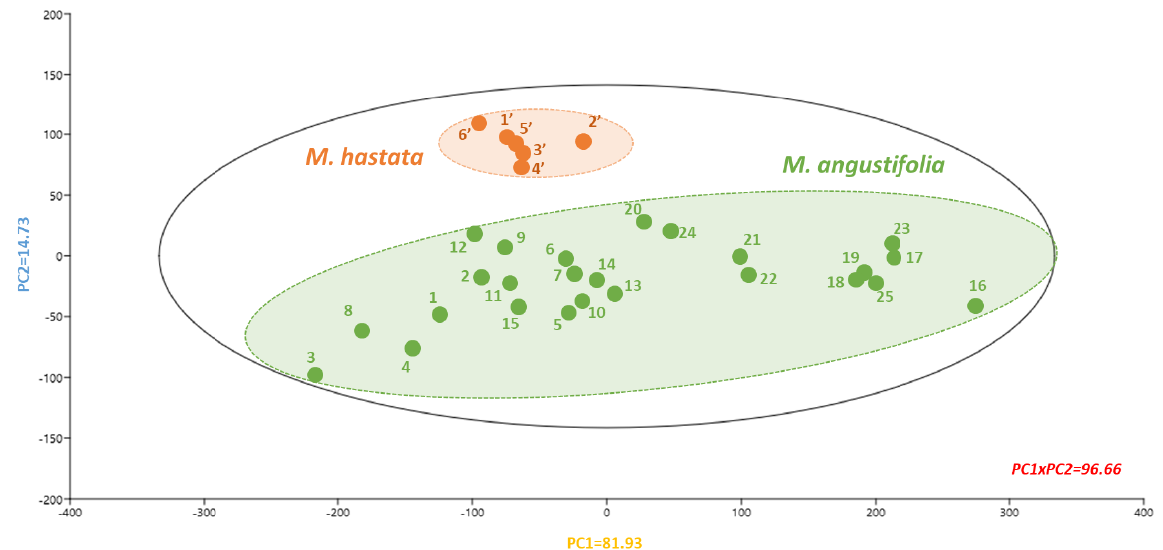
Figure 8. Principal component analysis linking the phytochemical profile as well as antioxidant capacity of extracts from different populations of the two Monochoria species. Variability of component 1 = 81.93% and component 2 = 14.73%. Each number represents the populations from M. angustifolia (in green) and M. hastata (in orange). The corresponding loading score plots for components 1 and 2 are presented in Figure S1.